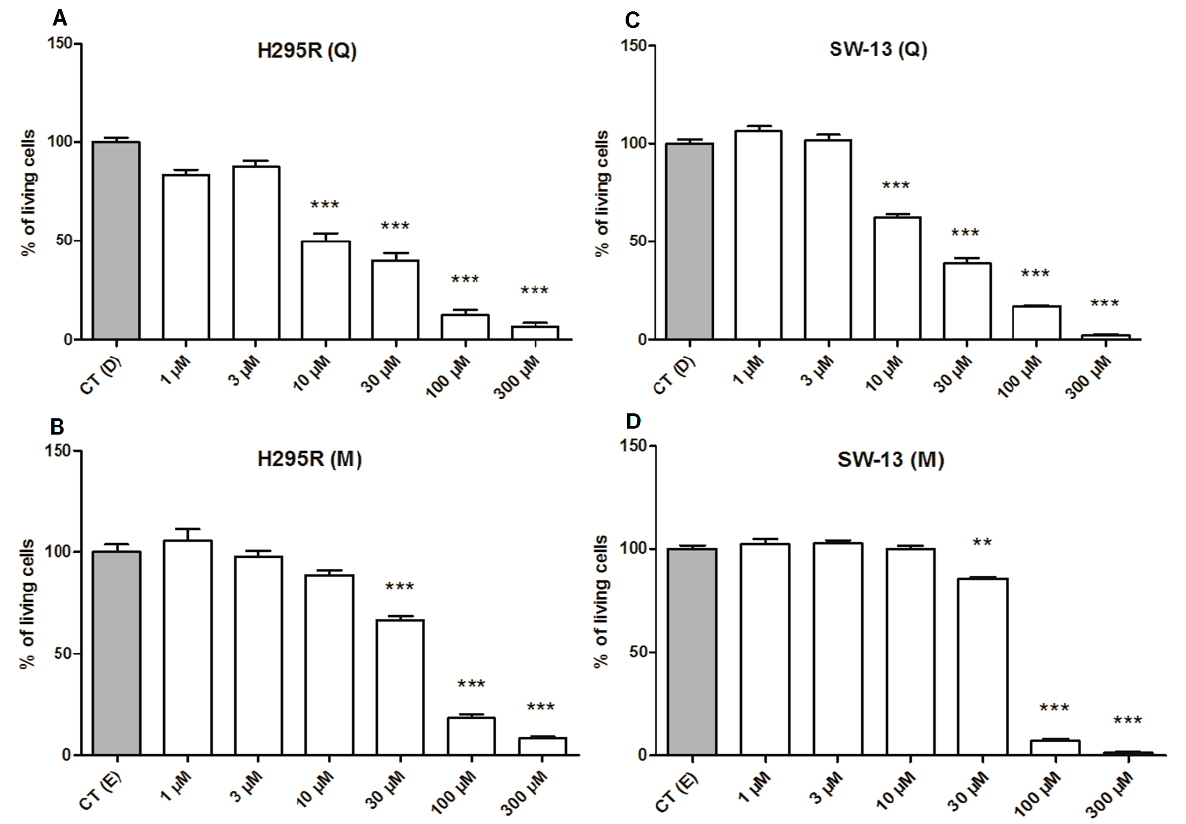
Figure 4. Cytotoxicity of quercetin and mitotane on the adrenocortical carcinoma cell lines. ( A , C ) Effect of quercetin (Q) on cellular viability measured by the MTT assay after 48 h of treatment for H295R and SW-13 adrenocortical carcinoma cell lines; ( B , D ) effect of mitotane (M) on cellular viability for H295R and SW-13 cell lines. ** ( p < 0.005); *** ( p < 0.0005) in comparison with respective controls.